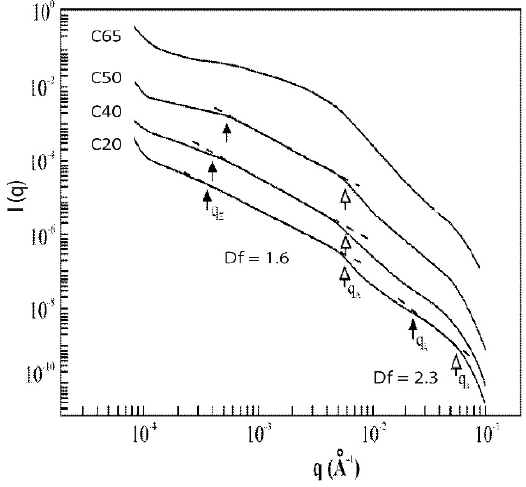
Figure 8. I(q) as measured by USAXS for the composite set (C20–C65) (from [48]) .